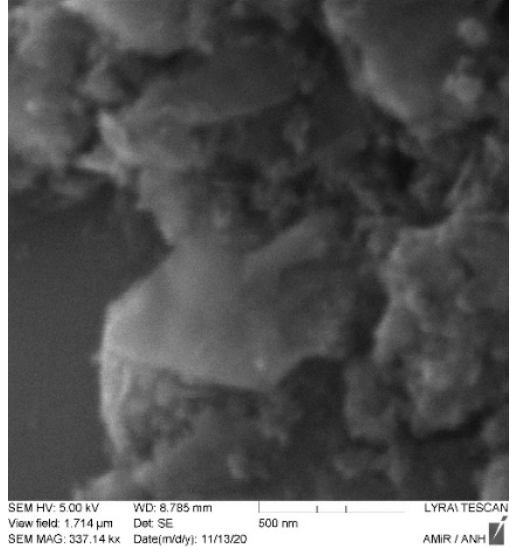
Figure 6. AFM characterization of a graphene flake: ( a ) AFM image with square a size of 250 nm; ( b ) cross-sectional measurement.